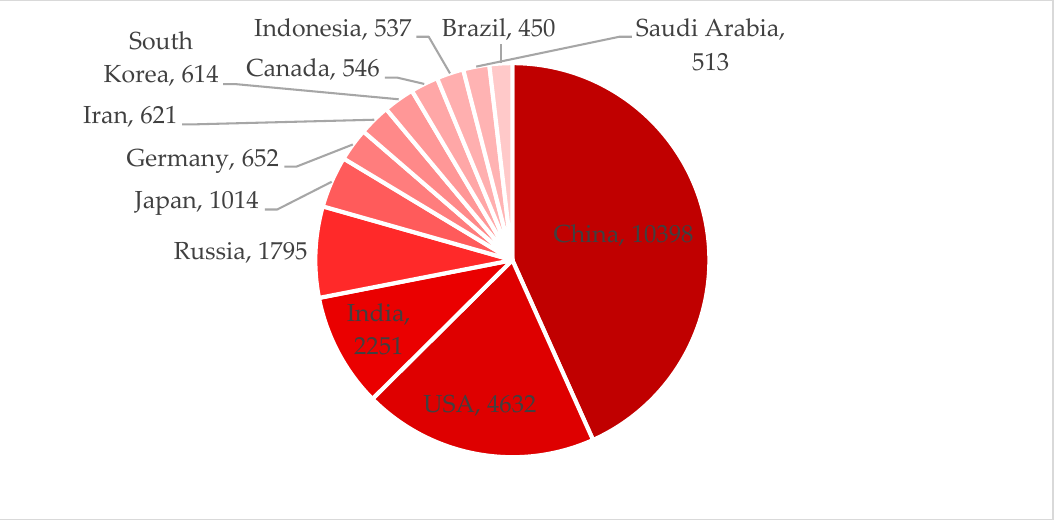
Figure 6. Structure of CO 2 emissions from fuel combustion by country, 2021, billions of metric tons of CO 2 [27].